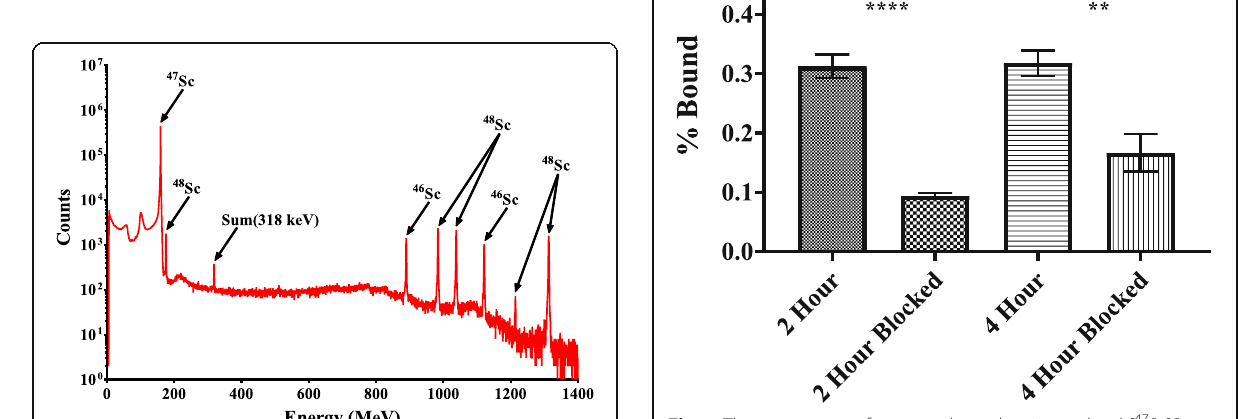
Fig. 5 The percentage of receptor bound or internalized [ 47 Sc]Sc- DOTATOC incubated with AR42J cells is shown on the ordinate axis at 2 and 4 h ( n = 4, 1 σ , SEM). Co-incubation with SSTR blocking agent Octreotide significantly decreased cell